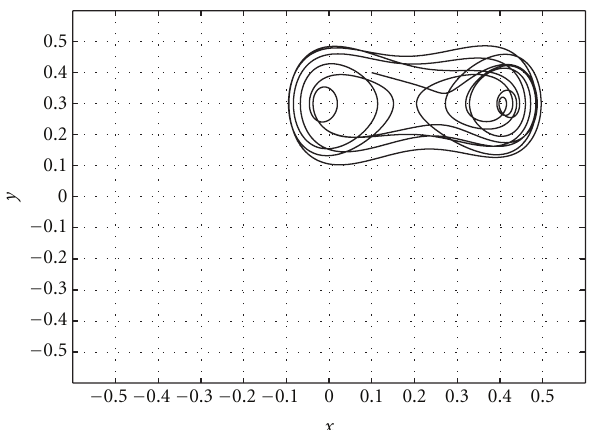
Figure 1: Reference irregular (chaotic) trajectory used to be fol- lowed by the RR